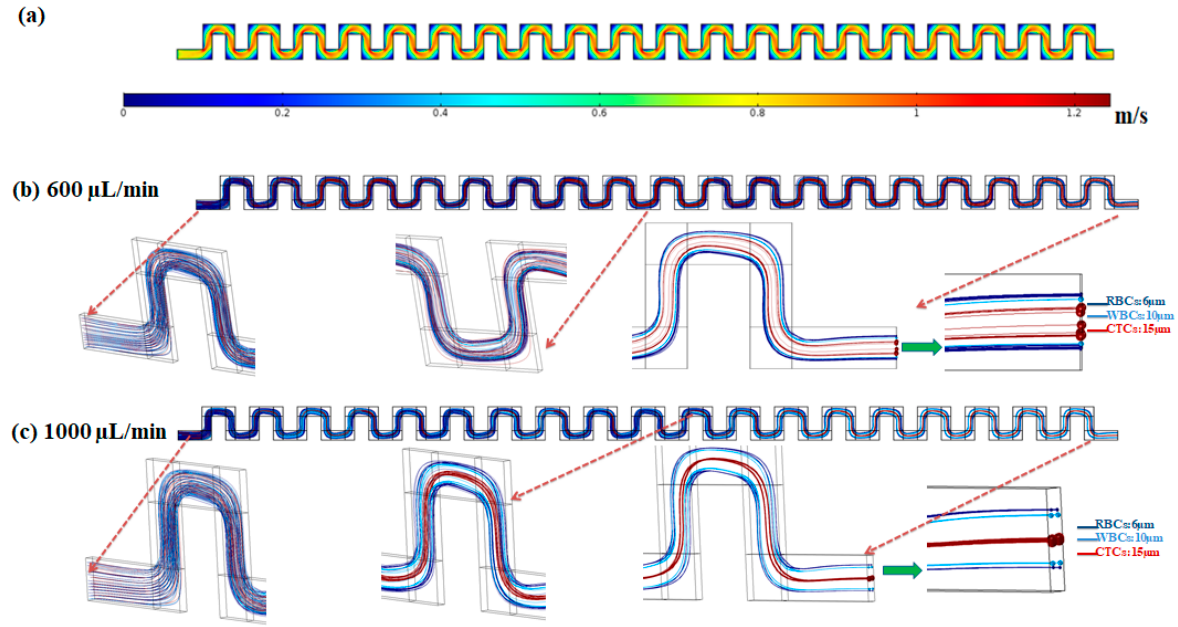
Figure 3. ( a ) Velocity distribution in the mid-plane of the inertial section of the channel at 1000 µL/min. ( b , c ) Particle trajectories at flow rates of 600 and1000 µL/min in the inertial section of the proposed hybrid device .